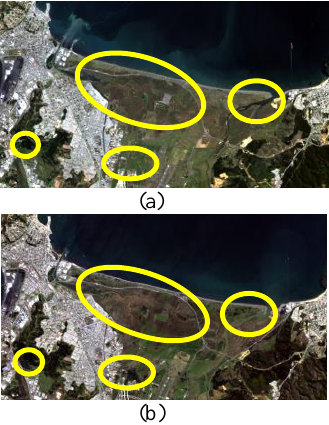
Figure 16. True-colour composite of optical images of ALOS/AVNIR-2: (a) Image before the disaster (2007/2/24) and (b) Image after the disaster (2007/9/24)